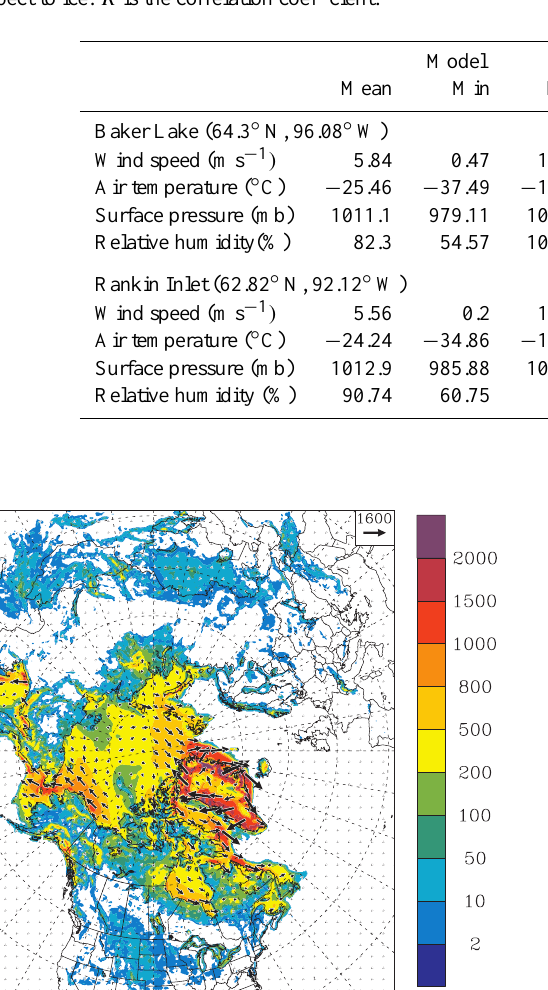
Table 2. Comparison of observed and simulated surface variables at Baker Lake and Rankin Inlet, Nunavut, Canada. The relative humidity is with respect to ice. R is the correlation coefficient.